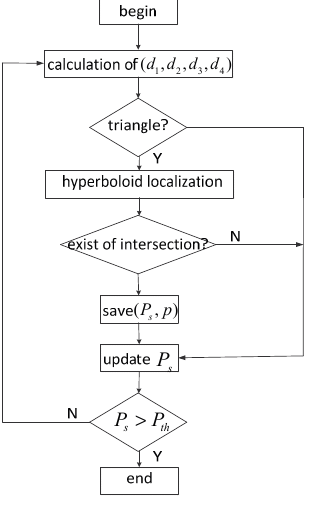
Figure 5. PHLA work